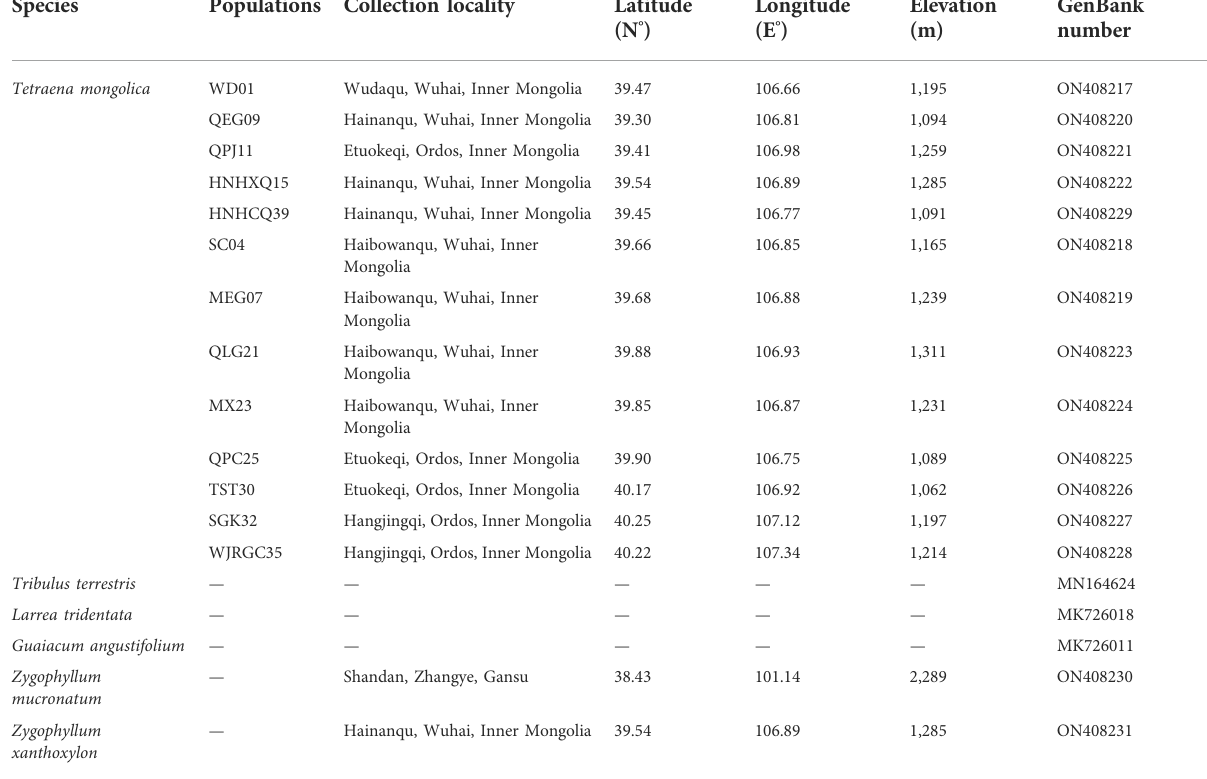
TABLE 1 Information of samples in this